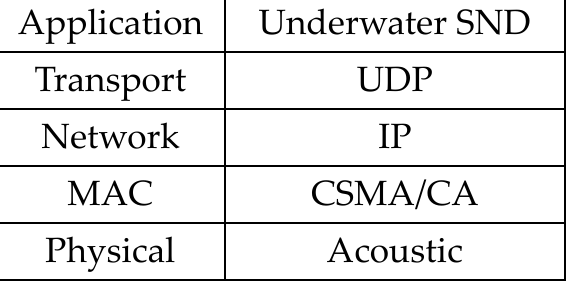
Figure 4. Assumed protocol stack.